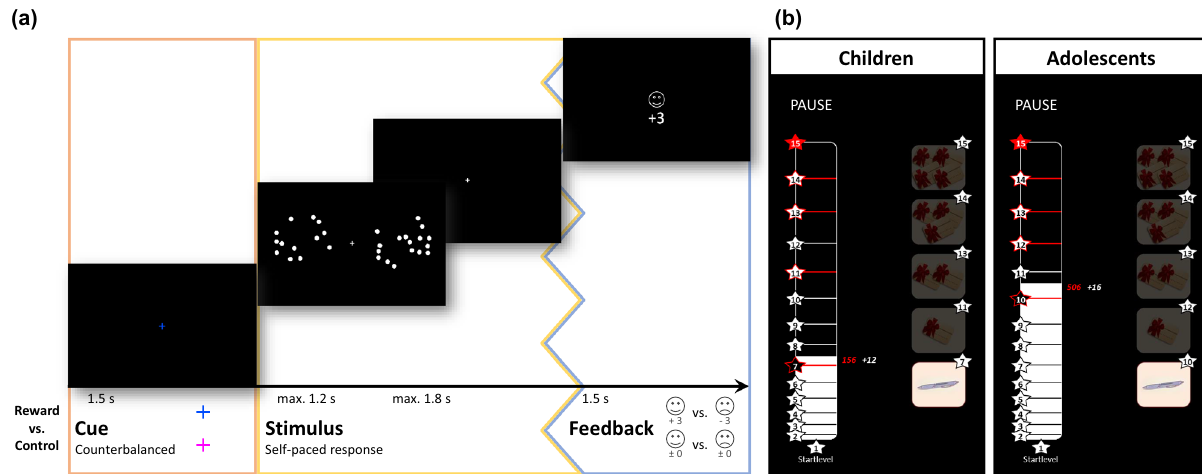
Figure 1. Incentivized dot comparison task: ( a ) Trial scheme showing the three phases (i.e. incentive cue, stimulus, feedback) of a correctly answered trial for the reward condition and below to it corresponding information on the control condition; ( b ) Scoring scheme shown to children (left) and adolescents (right) after each block—points collected in reward trials during the last block (white number), the accumulated total points (red number and white bar) as well as the reward level (level 1–15) with the corresponding win option (right